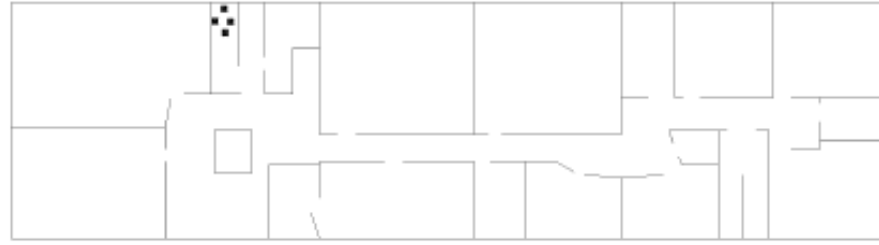
Figure 4. Start of the Operation. Note: each black square—each soldier in first fire team.